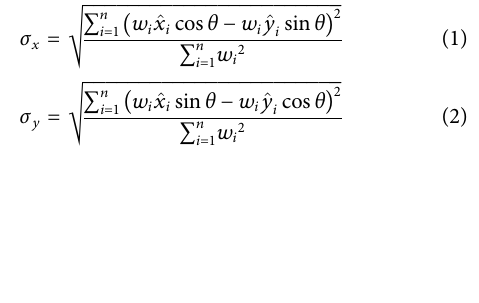
relative position of its distribution, the long axis characterizes its dispersion in the direction of the primary trend, and the azimuth re fl ects the direction of the primary distribution trend (Zhang et al., 2022).